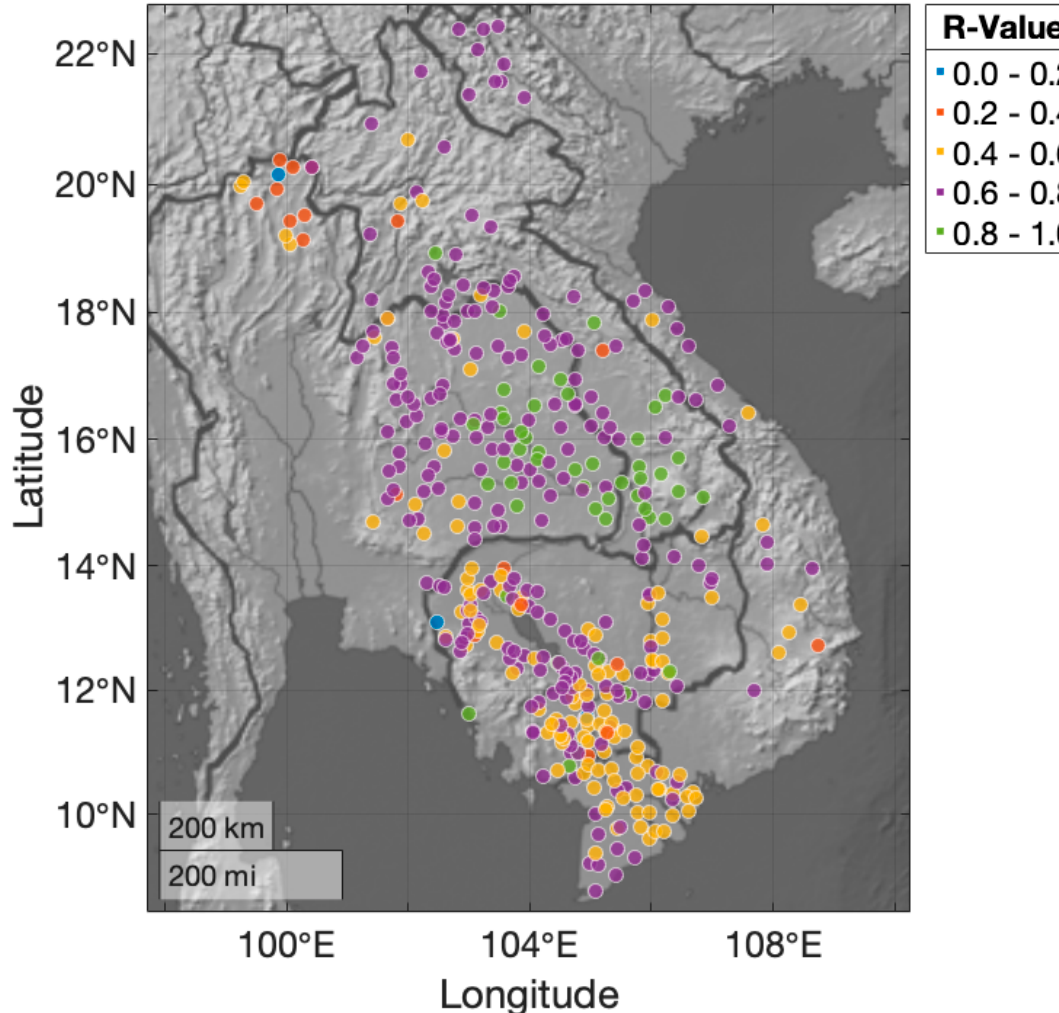
Figure 7. Spatial correlation results of mean r-value for each rain gauge stations against TMPA precipitation estimates for monthly rainfall.